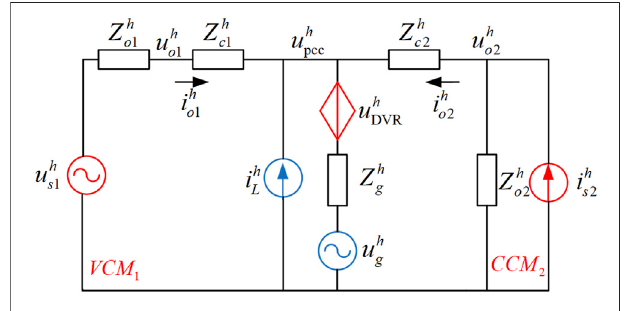
FIGURE 8 | Equivalent circuit with